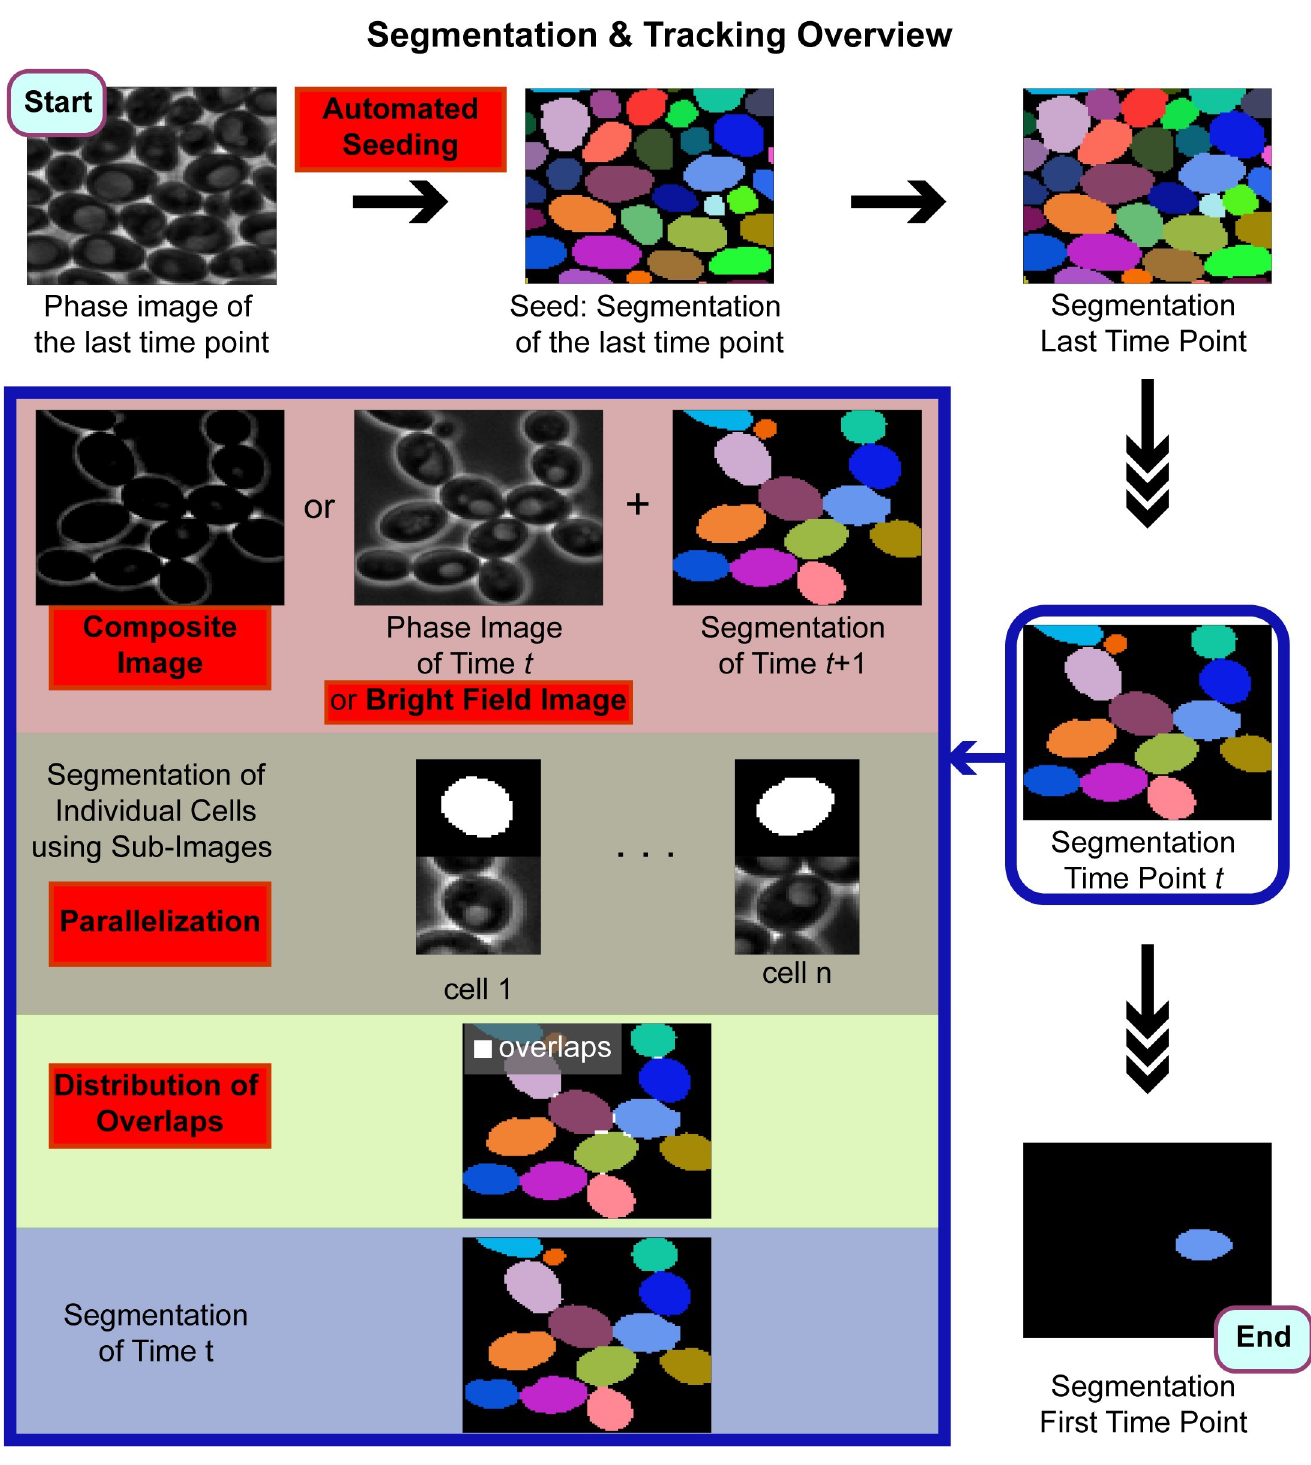
Fig 11. Overview of the segmentation and tracking algorithm. First, the automated seeding step segments the image of the last time point. This seed is fed into the algorithm, which segments the images backwards in time and uses the segmentation of the previous time point as a seed for segmenting the next time point. The segmentation at a given time point is summarized in the blue box. Improvements over the previously published algorithm [30] are highlighted in red boxes.